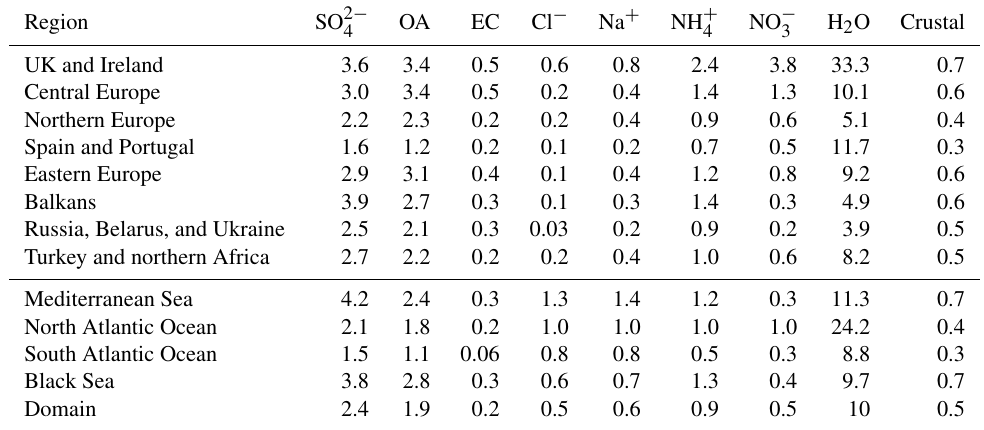
OA EC Cl − Na + NH + 4